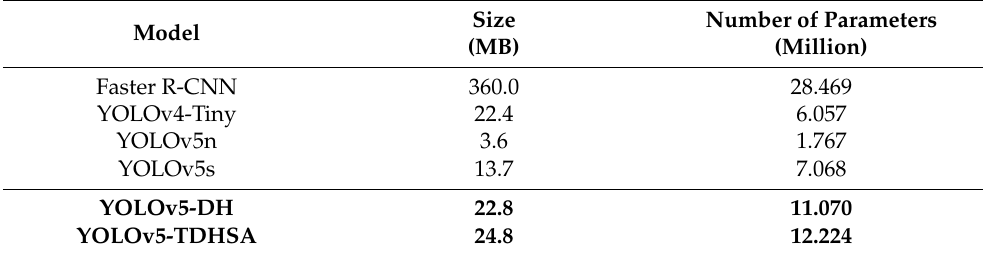
Table 3. The size and number of parameters of compared